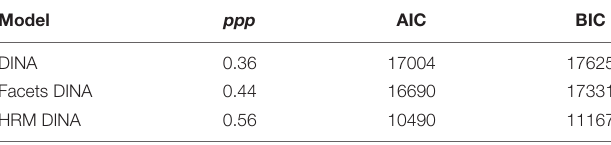
TABLE 6 | Model fit statistics of the three models in the empirical example.